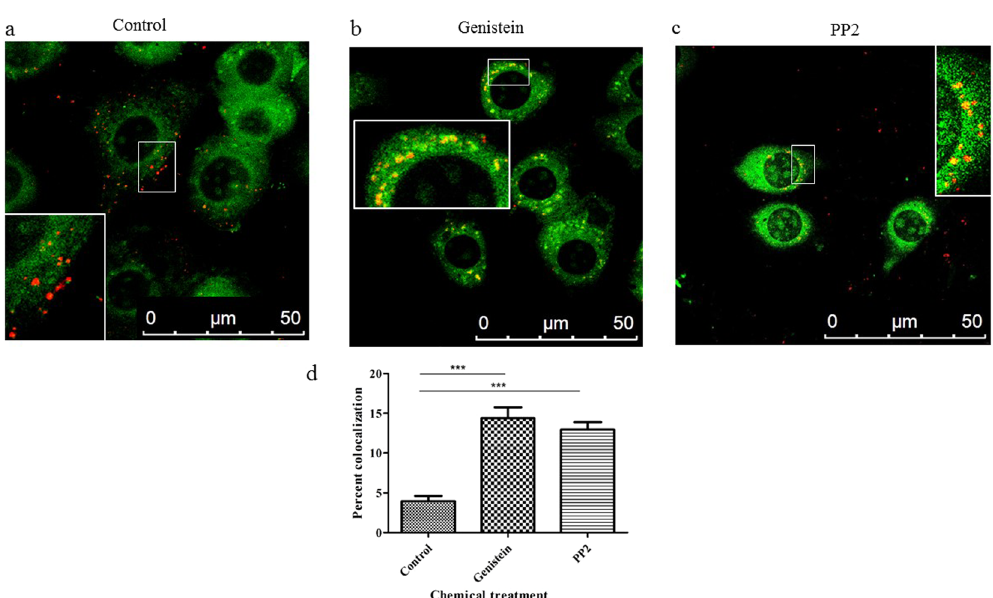
Figure 7. Genistein and PP2 route BmCPV to the wrong destination- lysosomes. ( a ) Normal BmN cells (control) were incubated with A546-labeled BmCPV virions and a lysosomal staining agent for 3 h; ( b ) BmN cells were treated with PP2 (0.16 μ M) for 30 min, followed by incubation with A546-labeled BmCPV virions and a lysosomal staining agent for 3 h; ( c ) BmN cells were treated with genistein (50 μ g/mL) for 1 h, followed by incubation with A546-labeled BmCPV virions and a lysosomal staining agent for 3 h; ( d ) quantification of the spectral overlap of BmCPV particles with lysosomes. The spectral overlap is presented as the percent co- localization ( n = 21 cells). Error bars indicate standard deviations. *** P <